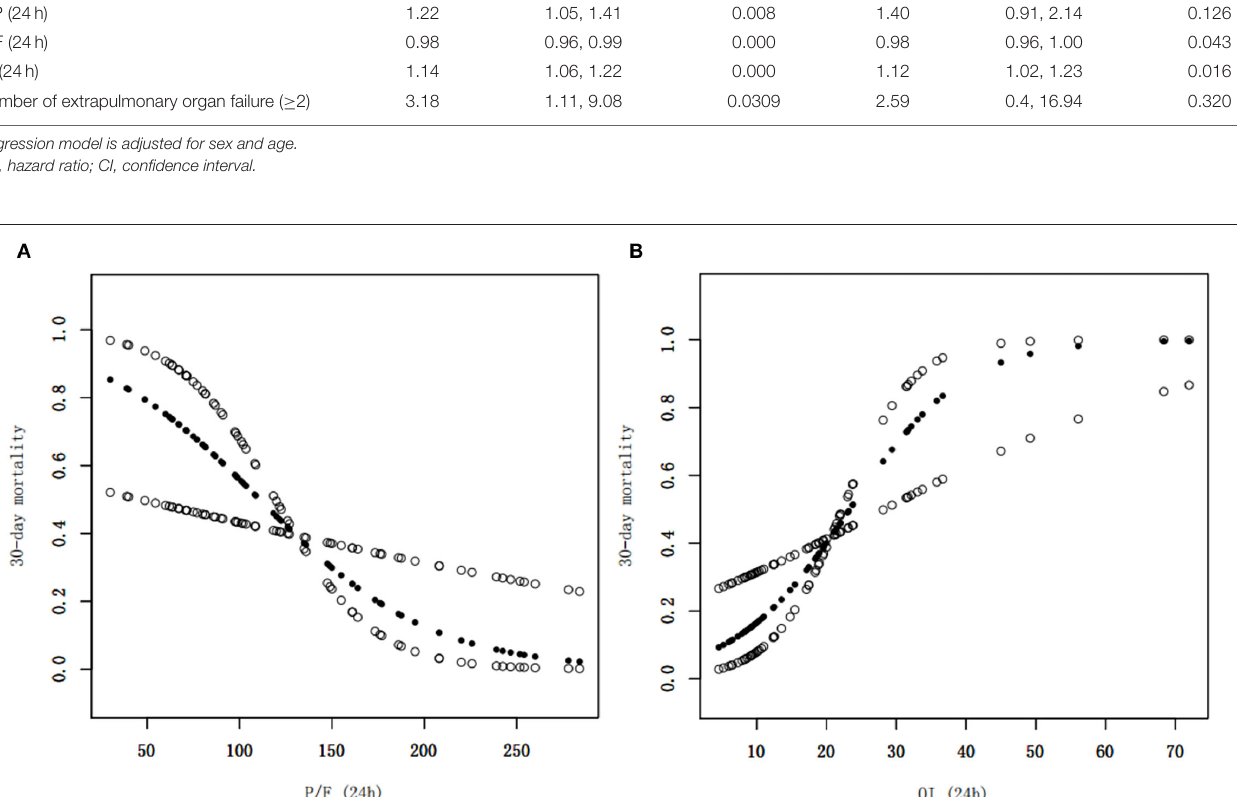
TABLE 5 | The association between oxygenation status at 24h and outcomes. At 24h Statistics day mortality